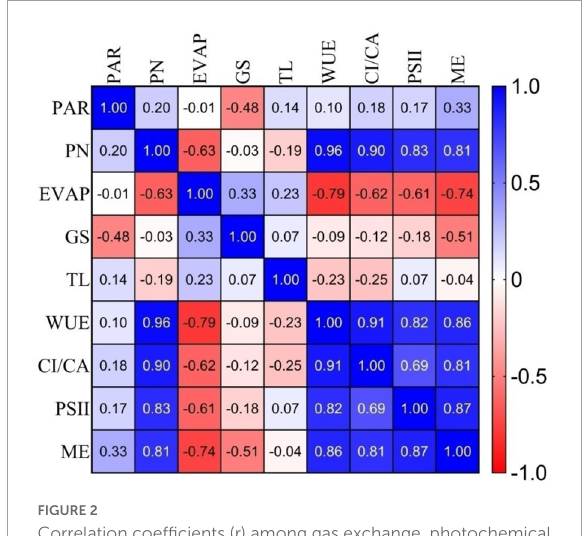
FIGURE2 Correlation coefficients (r) among gas exchange, photochemical efficiency of PSII and mesophyll efficiency parameters of selected germplasm. Where: PAR, Photosynthetic Active Radiation; PN, Net Photosynthesis; EVAP, Transpiration; GS, Stomatal Conductance; TL, leaf temperature; WUE, Water Use Efficiency; CI/CA, Carboxylation efficiency; PSII, Photochemical efficiency of PSII; and ME, Mesophyll